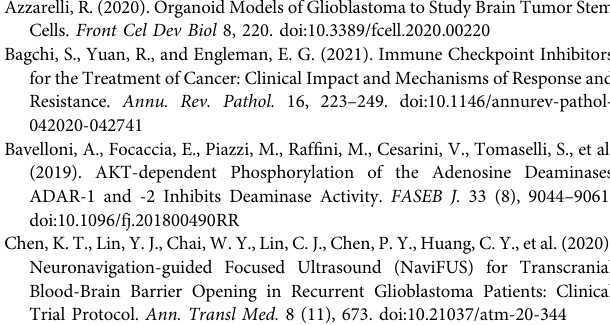
Supplementary Figure S4 | Correlation of ADARB1 expression with chemokines and receptors in GBM. (A) The correlation between ADARB1 expression and chemokines. And the top four chemokines showing the most signi fi cant correlation with ADARB1 expression. (B) The correlation between ADARB1 expression and receptors. And the top four receptors showing the most signi fi cant correlation with